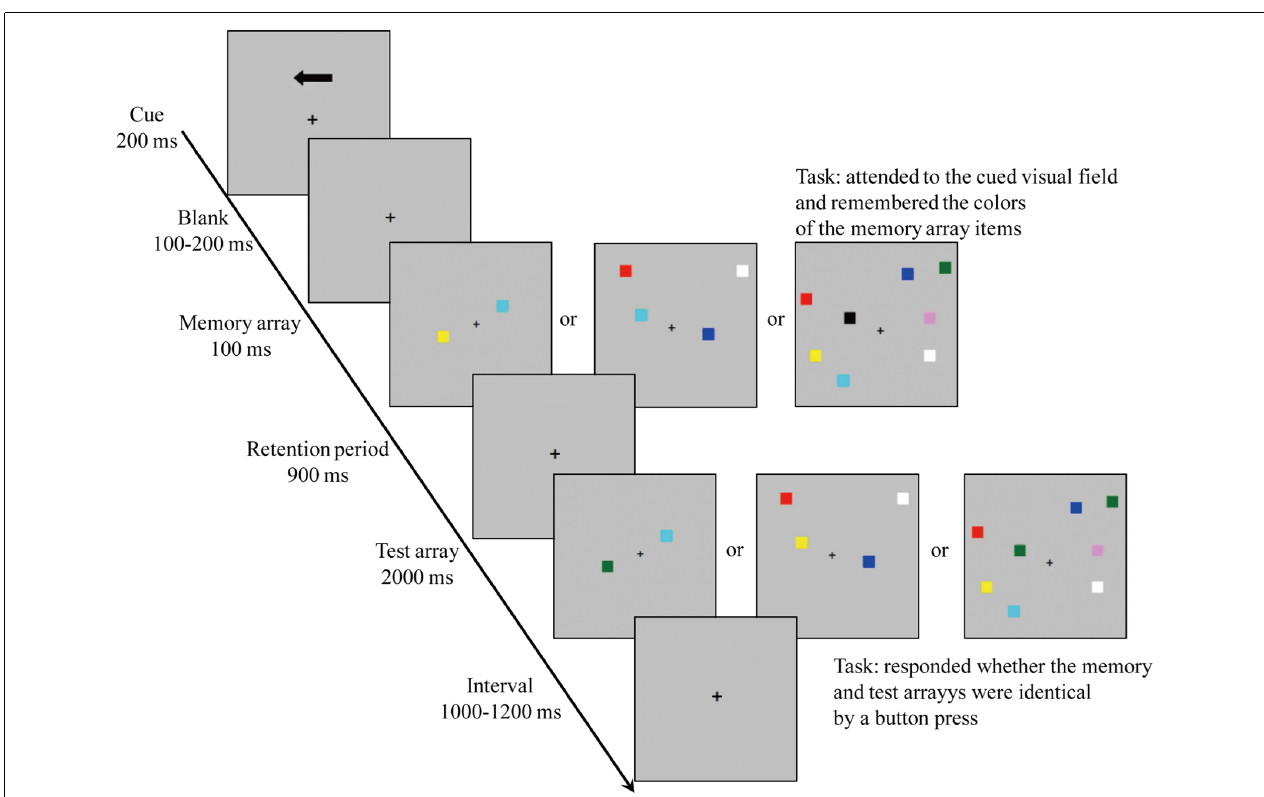
FIGURE 1 | The experimental